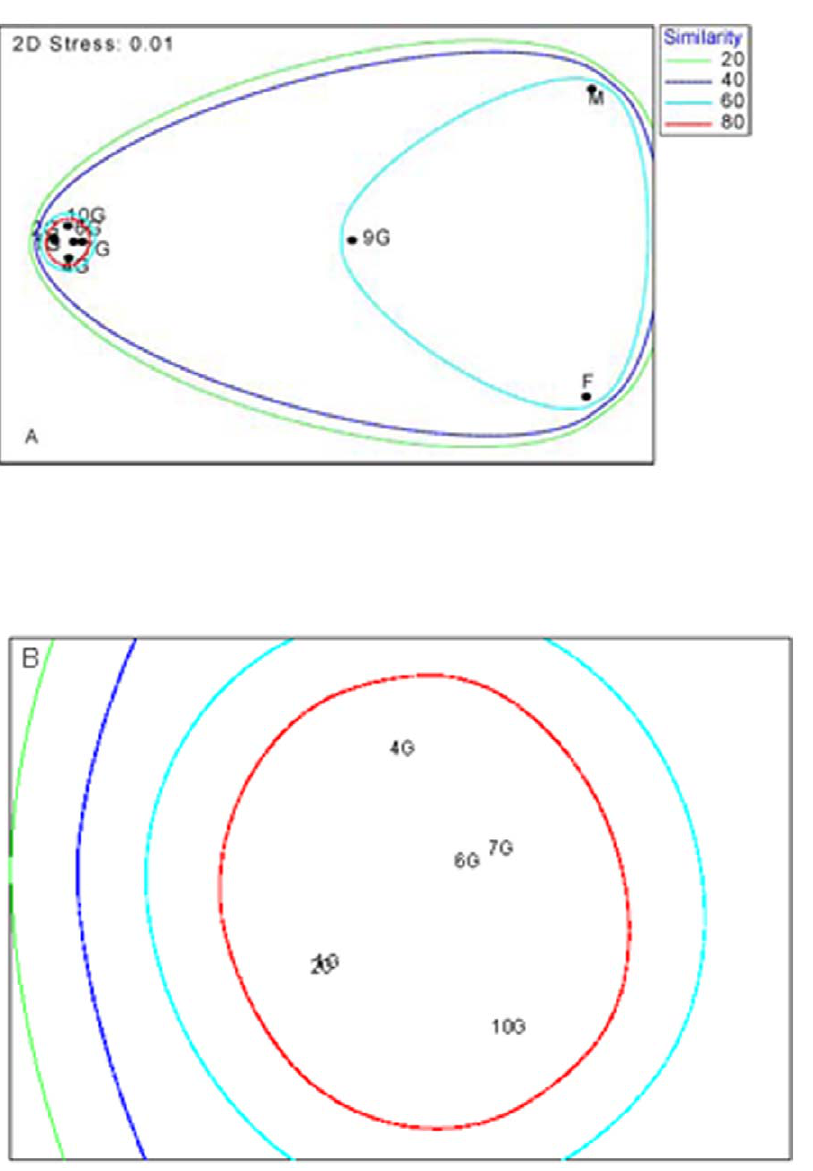
Figure 9. MDS ordinations of environmental variables. MDS ordination of stations along the Ellett Line transect, sampled during D257. Samples above 100 m depth were included, data were fourth root transformed. (a) all stations, (b) expanded view of stations 1G, 2G, 4G, 6G, 7G, 10G.